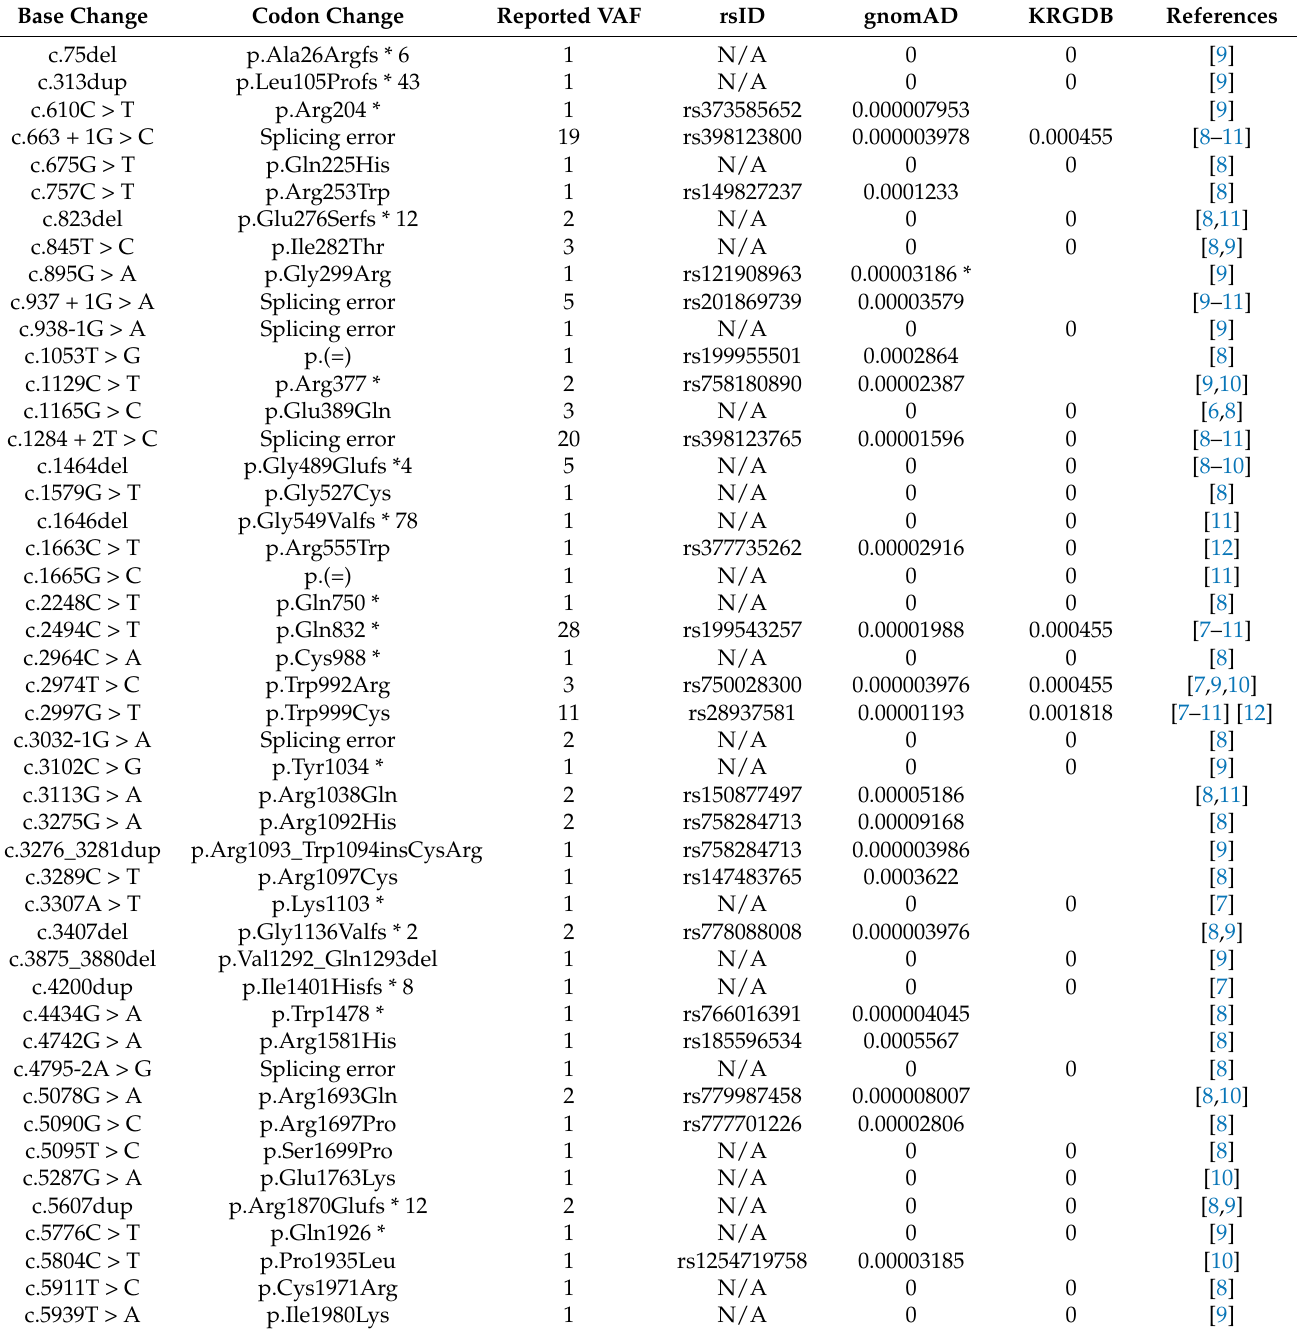
Table 2. 49 reported DYSF variants in 72 Korean Miyoshi muscular dystrophy type 1 or limb-girdle muscular dystrophy autosomal recessive type